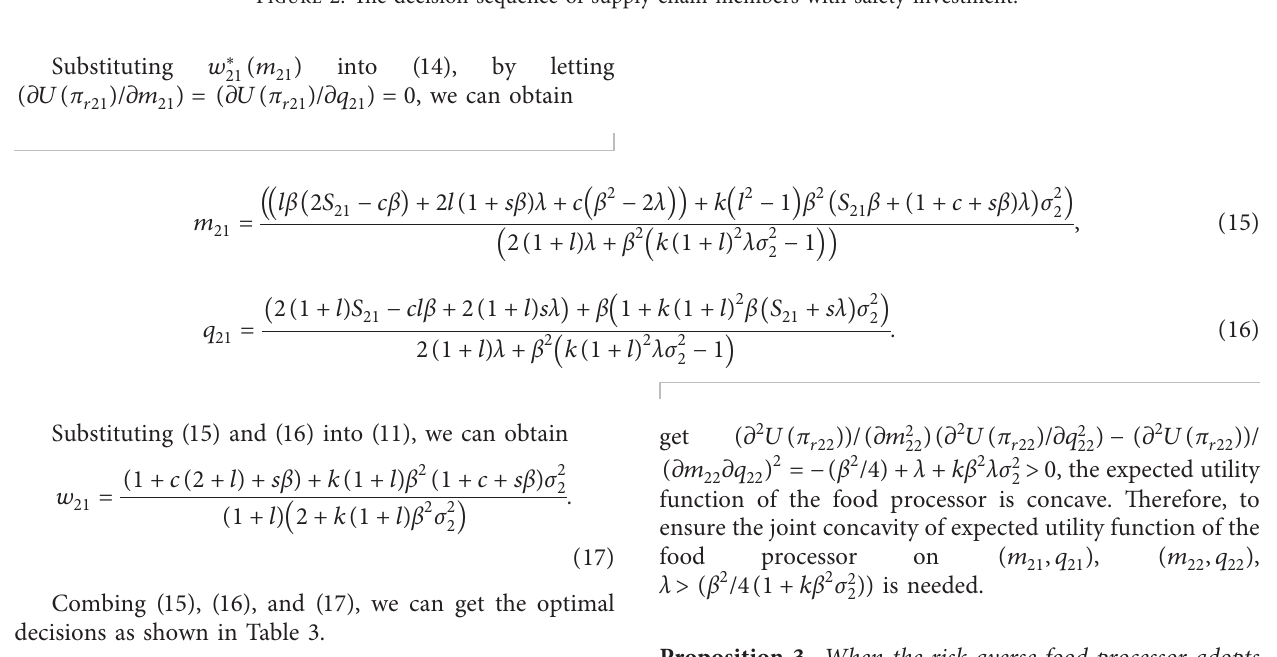
Figure 2: The decision sequence of supply chain members with safety